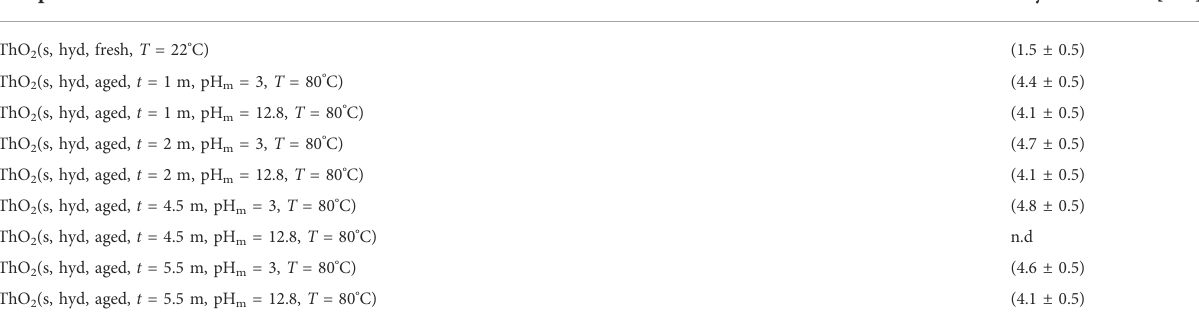
TABLE 1 Scherrer analysis of the ThO 2 (s, hyd, fresh) and ThO 2 (s, hyd, aged) solid phases investigated in this work. n.d. stands for not determined. Sample Crystallite size [nm]